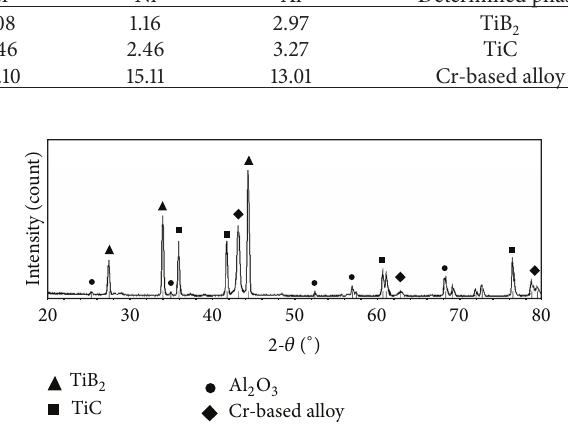
Figure 1: The XRD pattern of the TiC-TiB 2 ceramic